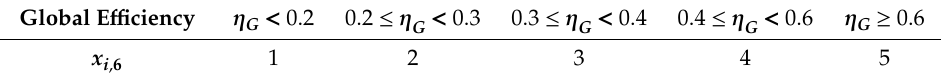
Table 6. Performance values x i ,6 for 6th criterion.